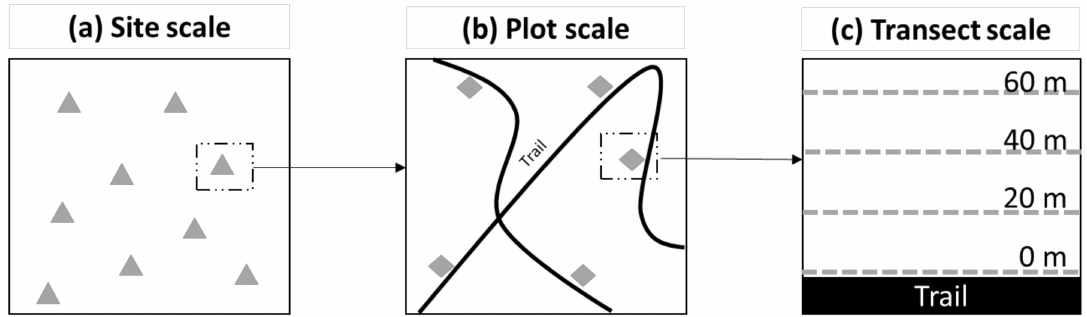
Figure 1. Sampling protocols at the site, plot, and transect scales. At the site scale ( a ), fifty sites (triangles) were sampled in 2014 by drag sampling an area of 2000 m 2 . At the plot scale ( b ), three public woodlands were intensively sampled in 2013 with several plots (diamonds) sampled along the trails (dark lines) during the summer. At the transect scale ( c ), four transects of 100 m (dotted lines) were sampled in each plot in 2013 at 0, 20, 40, and 60 m from the